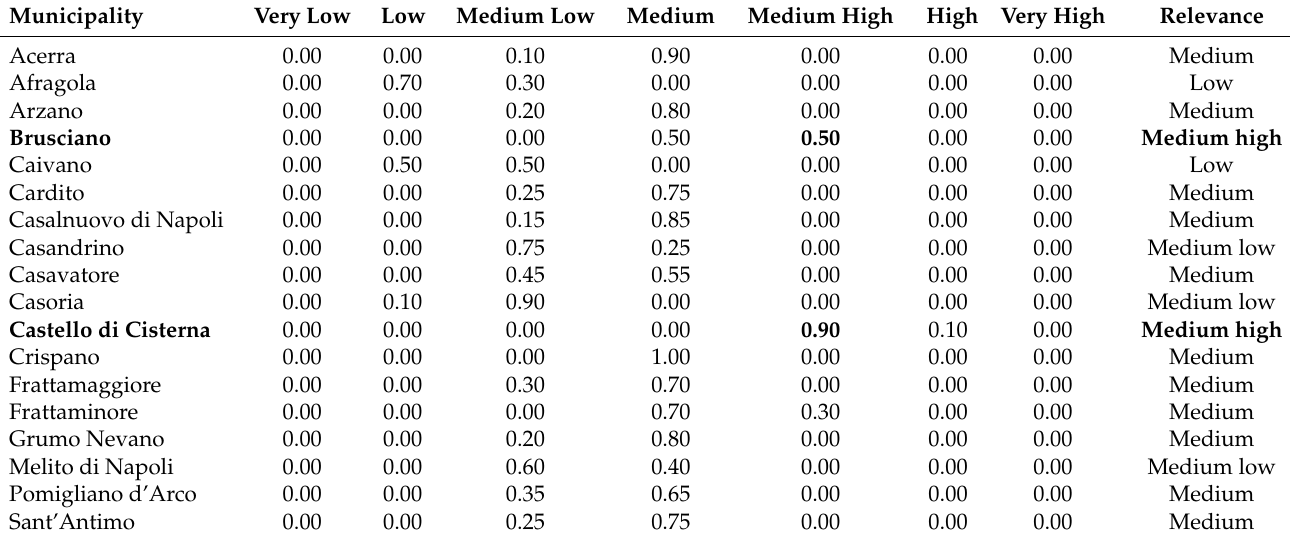
Table 4. Relevance of pleasant emotional categories in the year 2021.